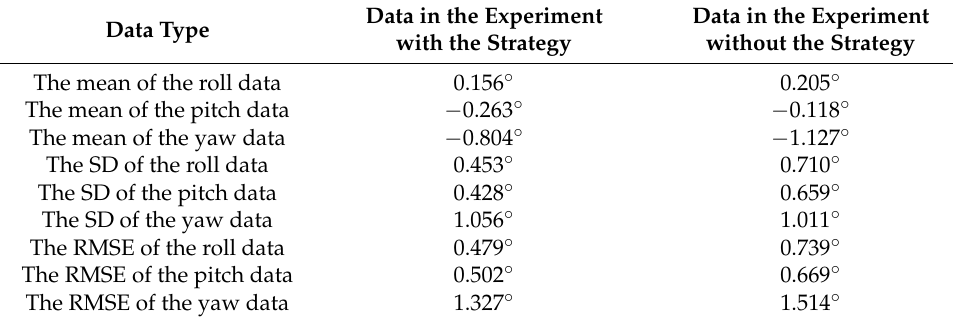
Table 4. Comparison of data in two experiments.